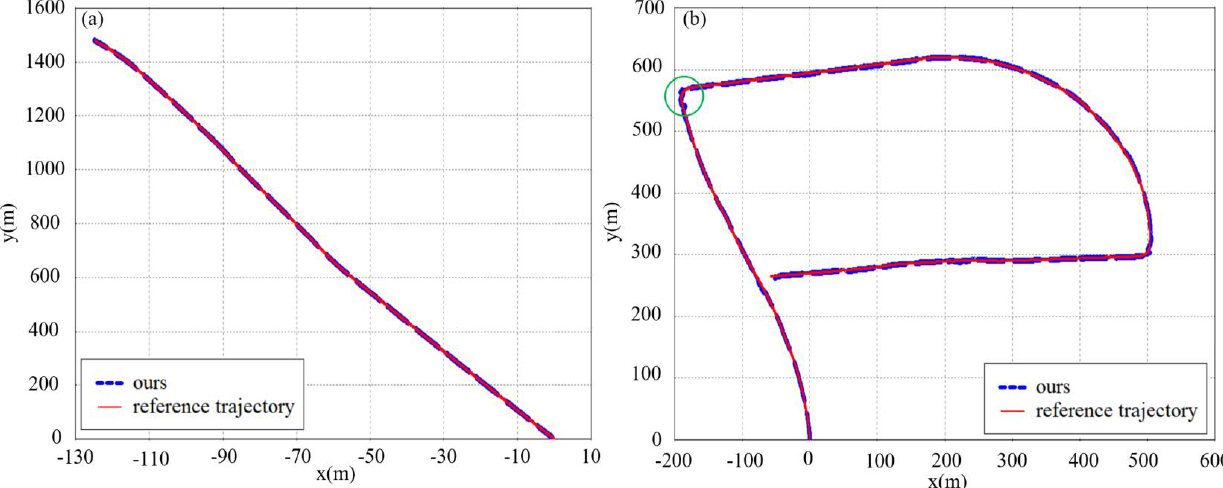
Figure 8. Comparison of localization results between the proposed method and the reference trajectories with field test data. ( a ) Field test data Site-1; ( b ) field test data Site-2.